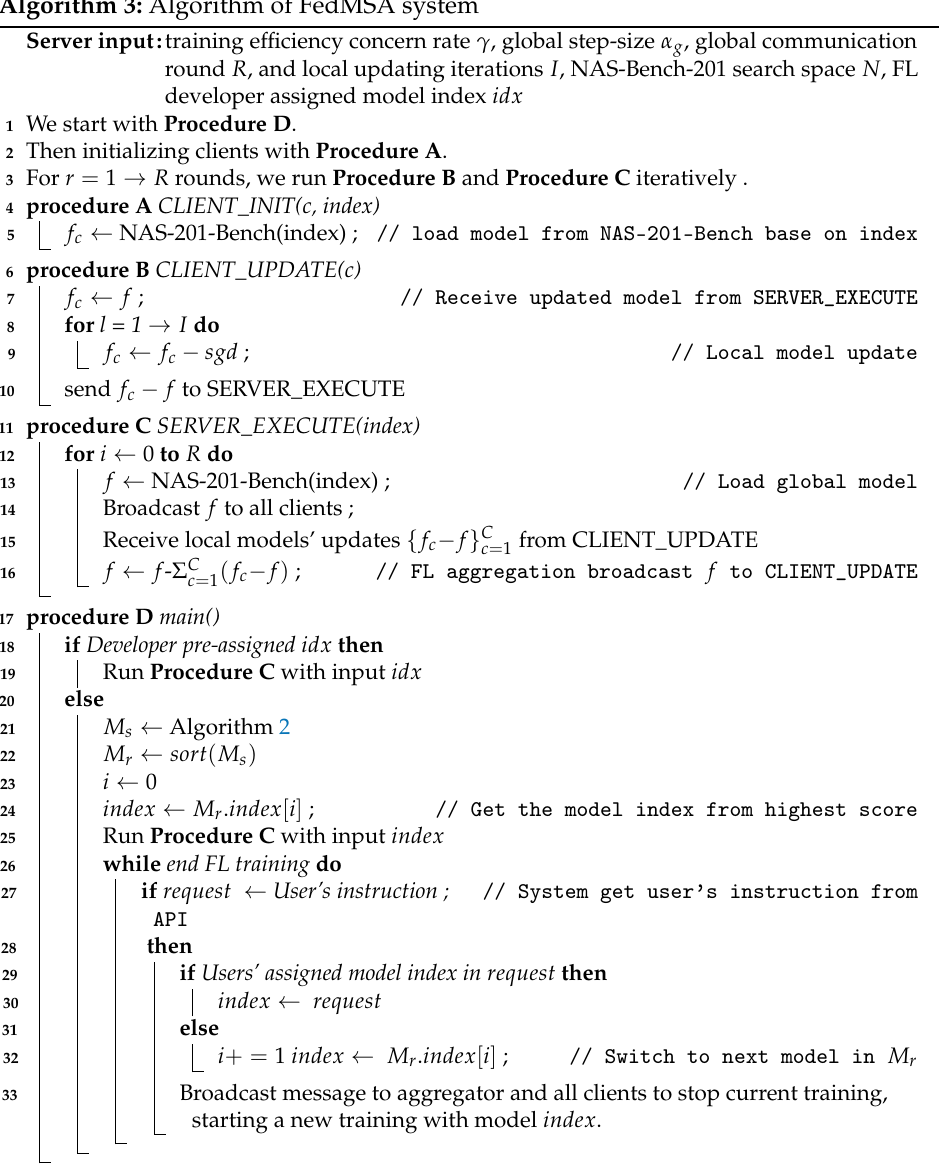
Algorithm 3: Algorithm of FedMSA